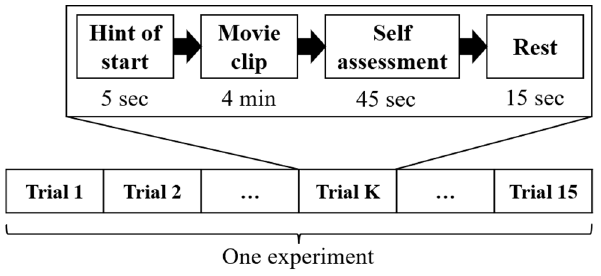
Figure 1. The protocol of the experiments in the SEED dataset [29].